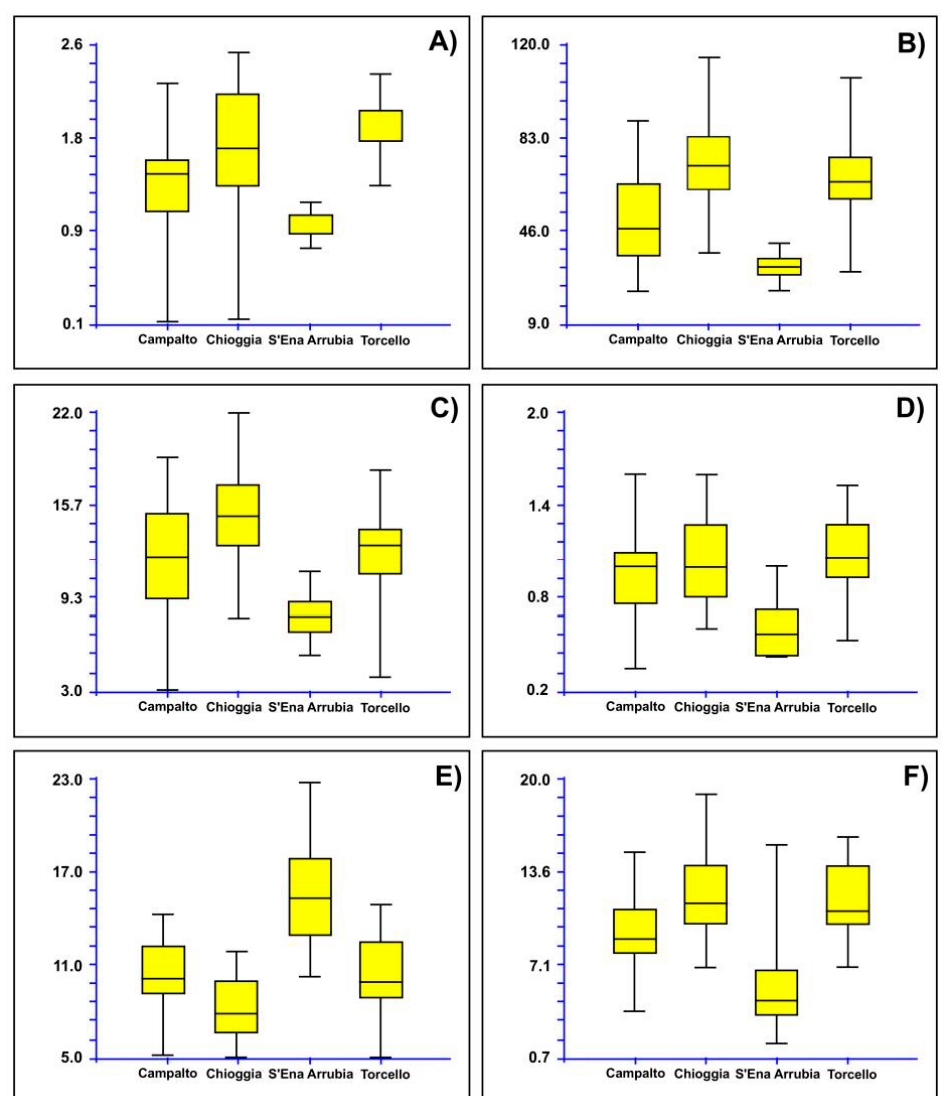
Figure 12. Box plots showing the variability of the diagnostic character derived from PCA: ( A ) height of the side flower of the third segment, ( B ) length of the spike, ( C ) distance from the tip of the third fertile segments to apex of middle flower, ( D ) number of fertile segments, ( E ) length of the second internode, ( F ) length of the ultimate internode. Campalto, Chioggia, and Torcello populations in Venetian lagoon; S’Ena Arrubia population in Sardinia Island.